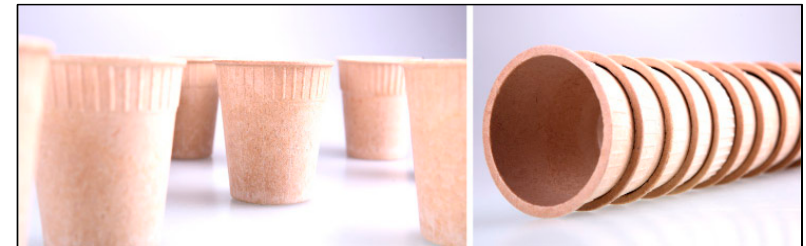
Figure 16. Food packaging from cassava starch and plant celluloses [117].